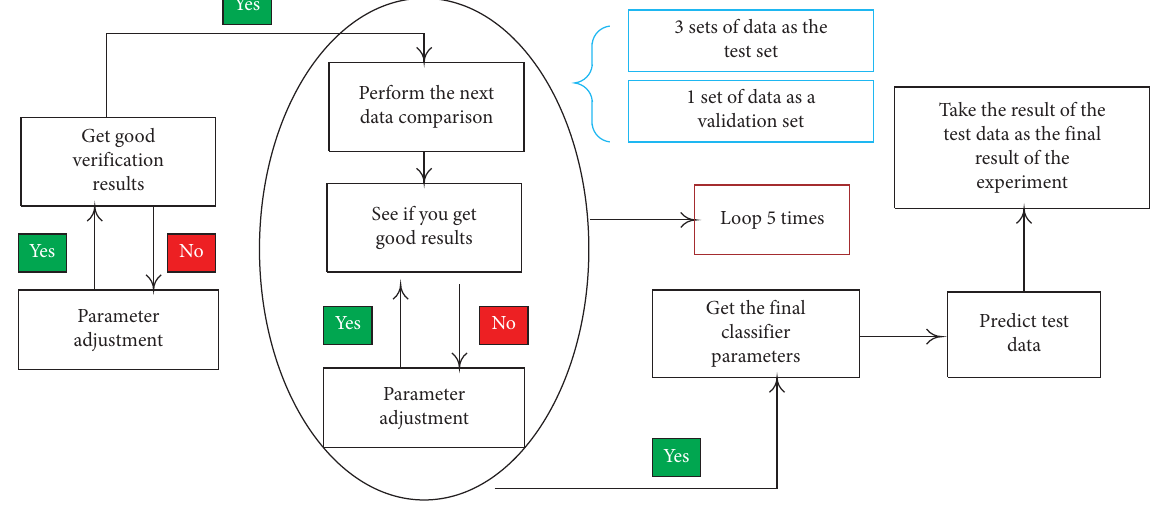
Figure 4: K -fold crossvalidation process.